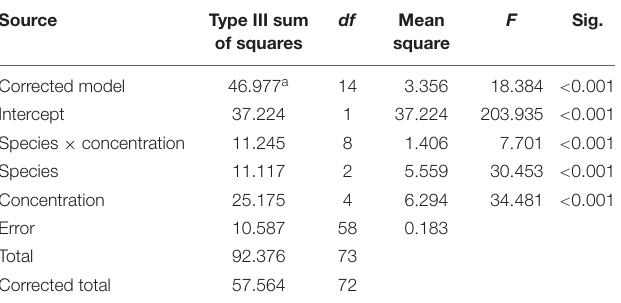
TABLE 2 | Nonlinear exponential regressions between clearance rates and Aureoumbra lagunensis cell densities.